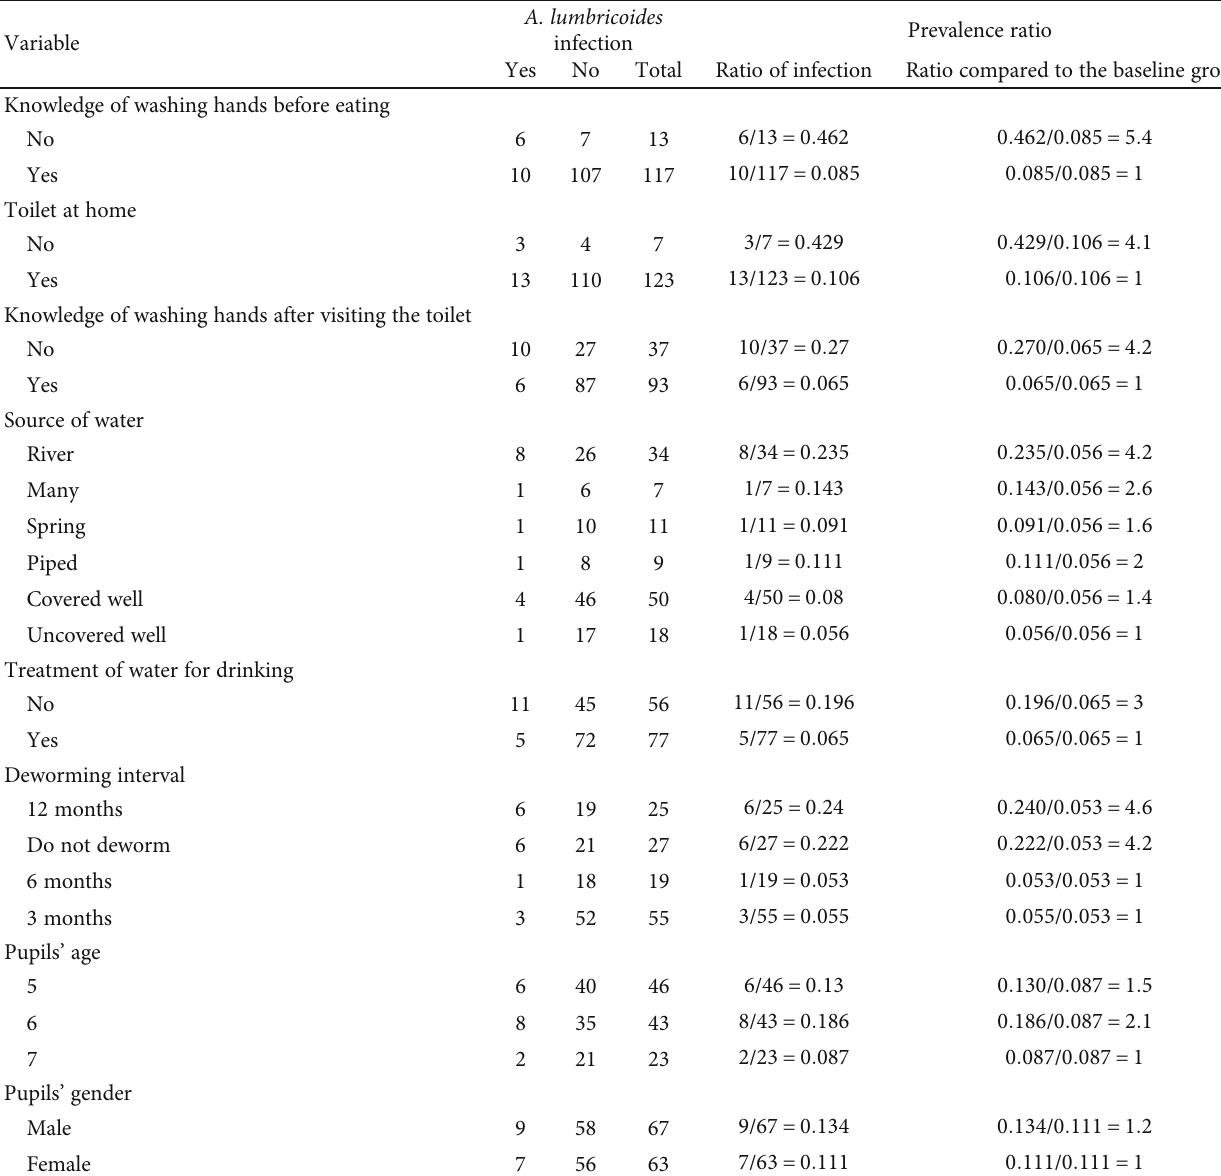
Table 2: Association between di ff erent factors and prevalence of A.